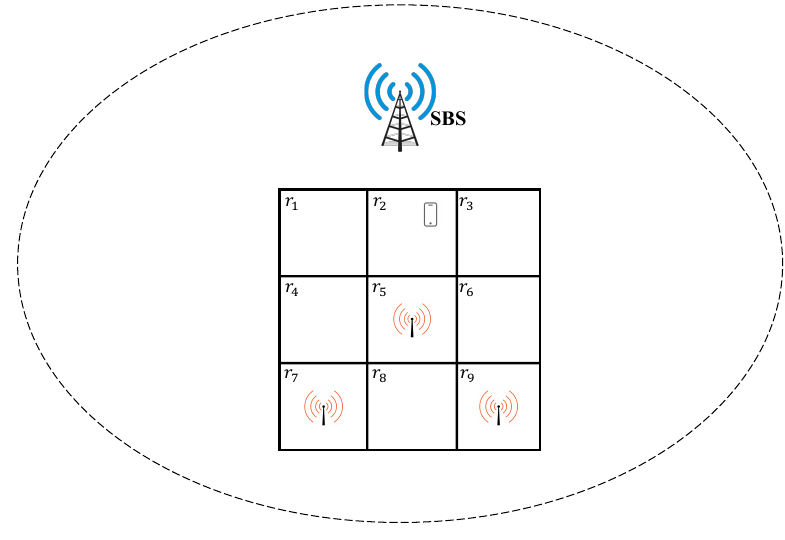
Figure 4. A sample